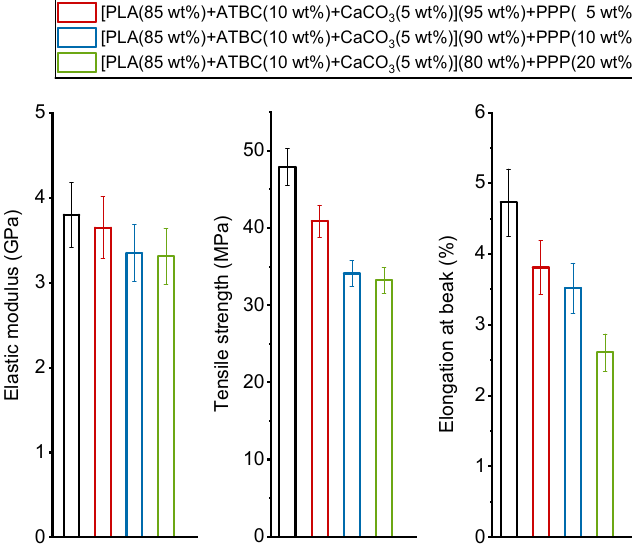
Figure 7. Elastic modulus, tensile strength, and elongation at break of the PLA-based matrix and biocomposites indicated in the legend.